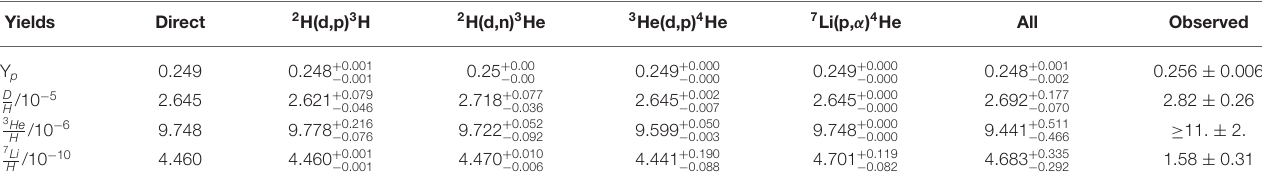
TABLE 6 | Primordial abundances as predicted by the Kawano code changing the reaction rate sets (described in the text) and compared with the observational results (last column). Yields Direct